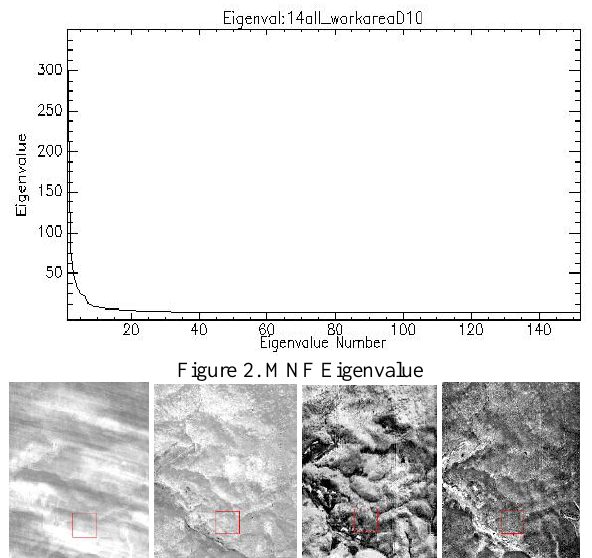
Figure 3. MNF images for the CASI_SASI data. (left to right)